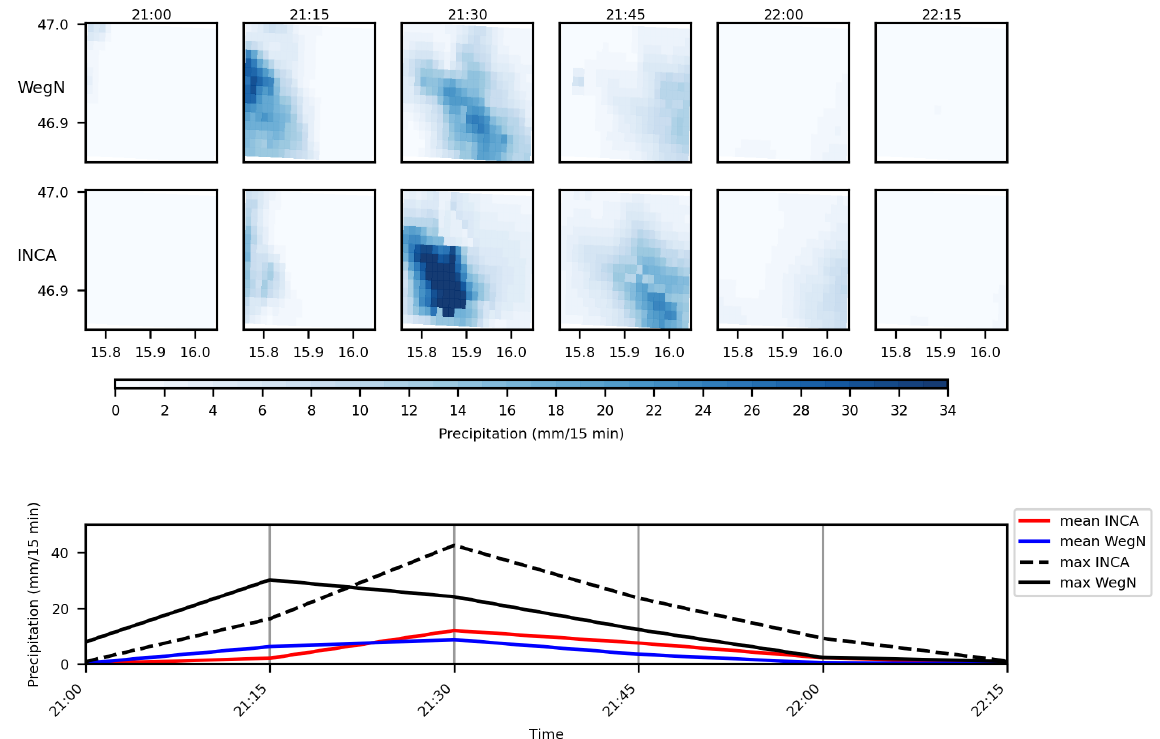
Figure 13. An event on 16 August 2016 in WegenerNet (top) and INCA (center) and time series of maximum and area-mean values in INCA and WegenerNet